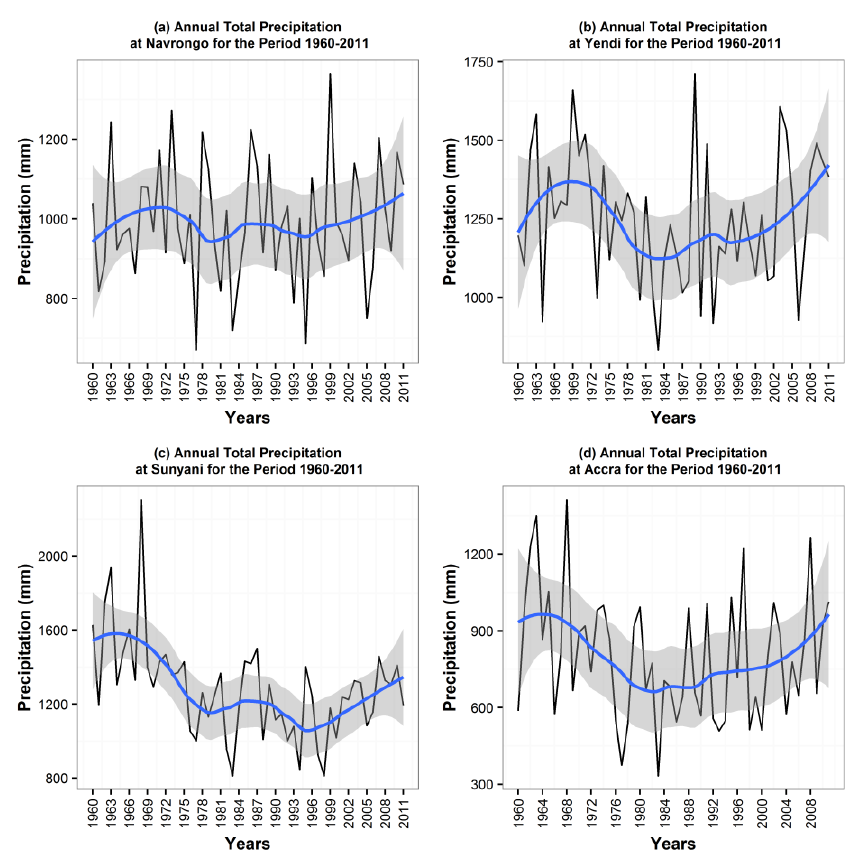
Figure 4. Rainfall times series of four selected stations in Ghana. The blue line or regression line represents a smoother (mean of annual precipitation at each year). The grey band is the display of the confidence interval (95% confidence interval) around the smoother. This helps to see the overall trend in the precipitation. Note that this stands for all the following graphs in this paper.